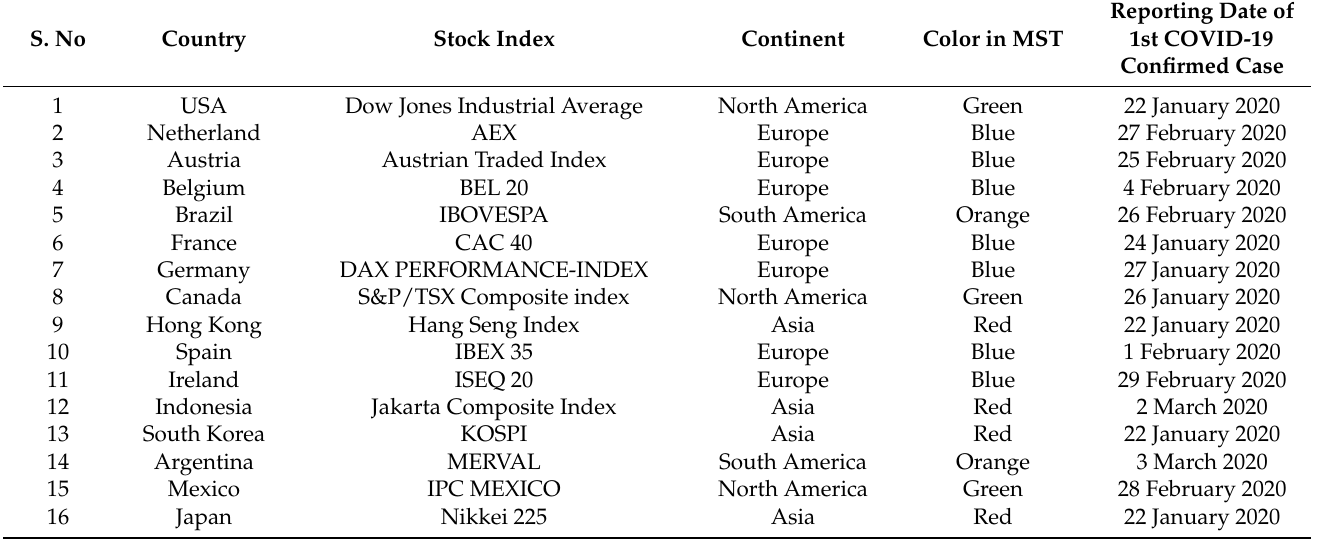
Table A1. List of countries with the respective stock index, classified by geographical region, color in the MST, and the reporting date when the first COVID-19 case was confirmed by the